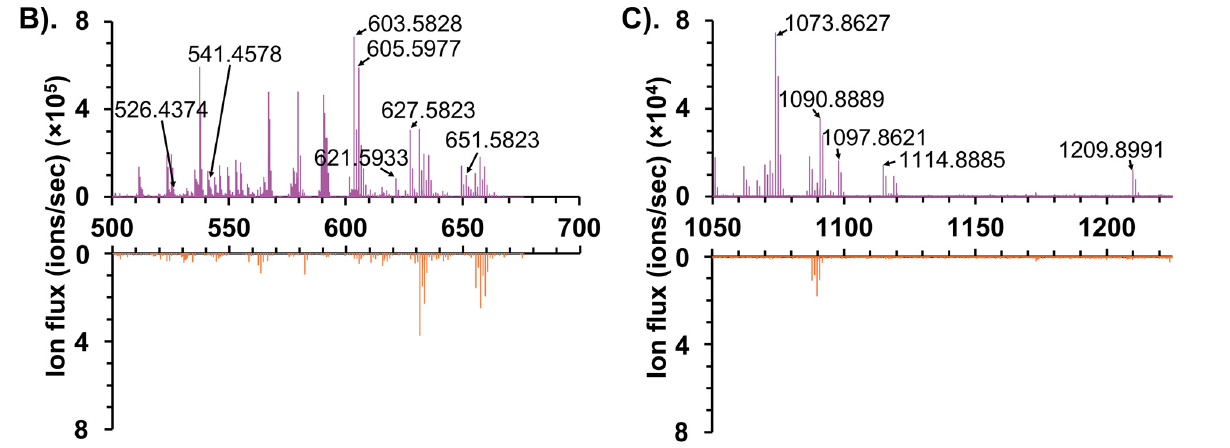
Figure 2. Comparison of mass spectra from rat liver sections between [C 5 (bpyr) 2 ] 2+ adducted positive ionization mode (purple, top) and positive ionization mode (orange, bottom); ( A ). Full mass spectrum at 450–1250 m / z ; ( B , C ). Zoomed-in mass spectra with labeled m / z related to adducts with [C 5 (bpyr) 2 ] 2+ .